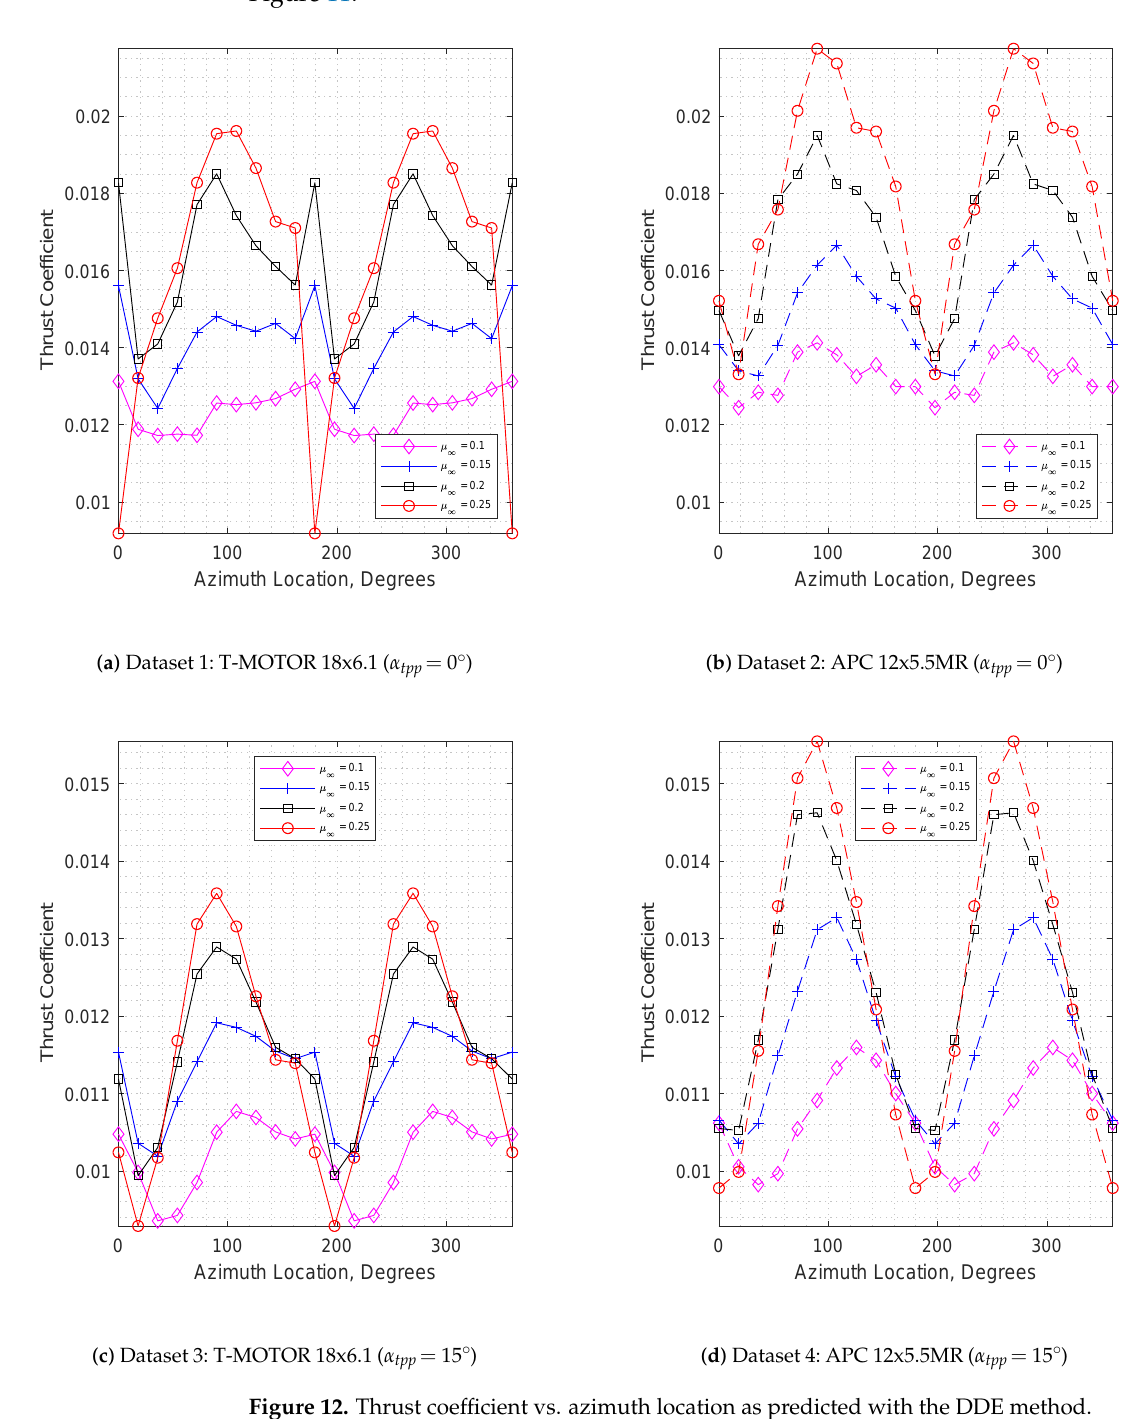
50 ◦ after the primary peaks. To explain 329 −